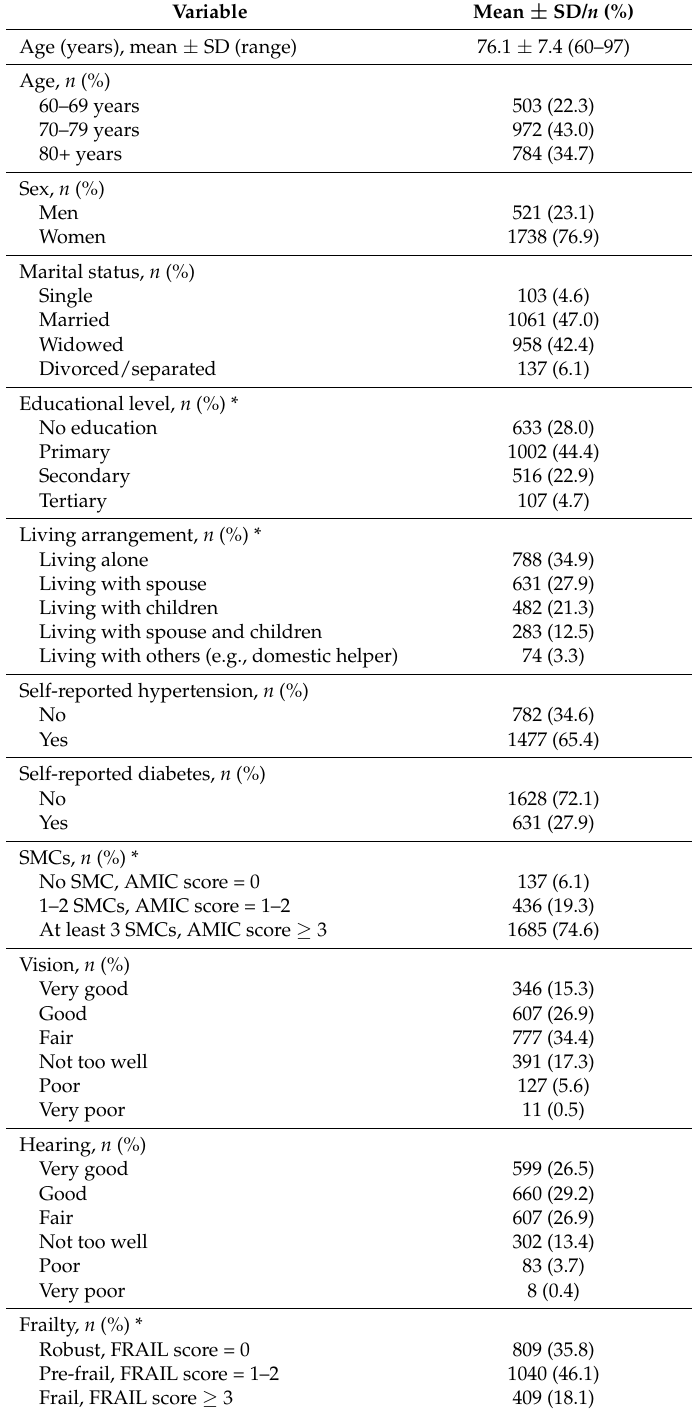
Table 1. Baseline characteristics of the study population ( n =